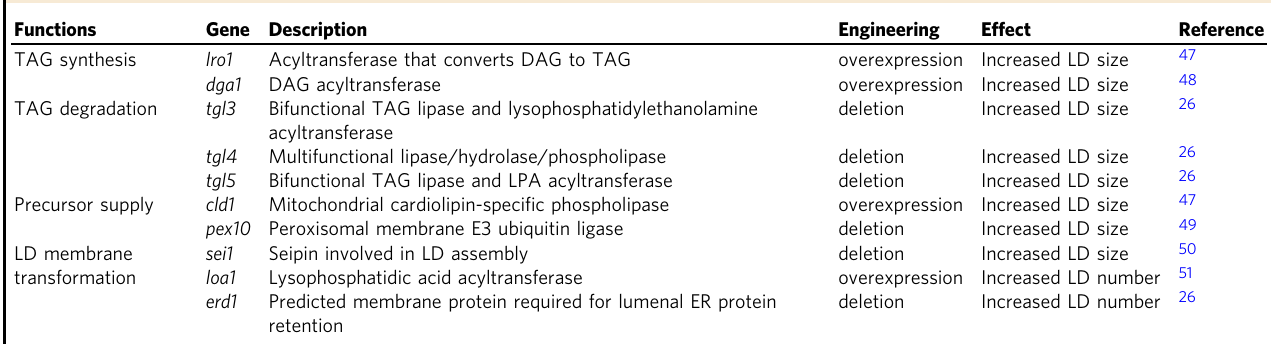
Table 1 Ten select genes associated with LD biogenesis and